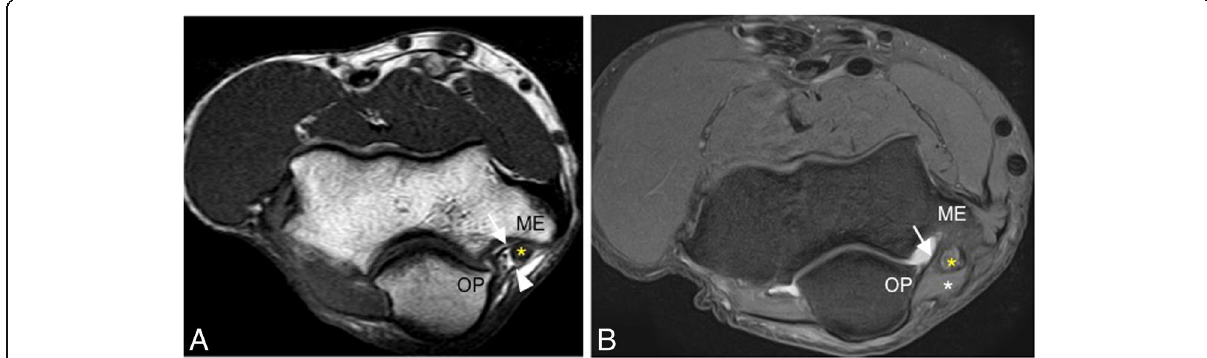
Fig. 6 Axial T1-weighted MRI ( a ) and axial FS PD-weighted MRI ( b ) in two different healthy volunteers showing the intact posterior bundle of the medial collateral ligament complex (white arrows). It extends from the posterior aspect of the medial epicondyle (ME) to the medial aspect of the olecranon process (OP). Cubital tunnel retinaculum (white arrowhead). Ulnar nerve (yellow asterisks). Anconeus epitrochlearis muscle (white